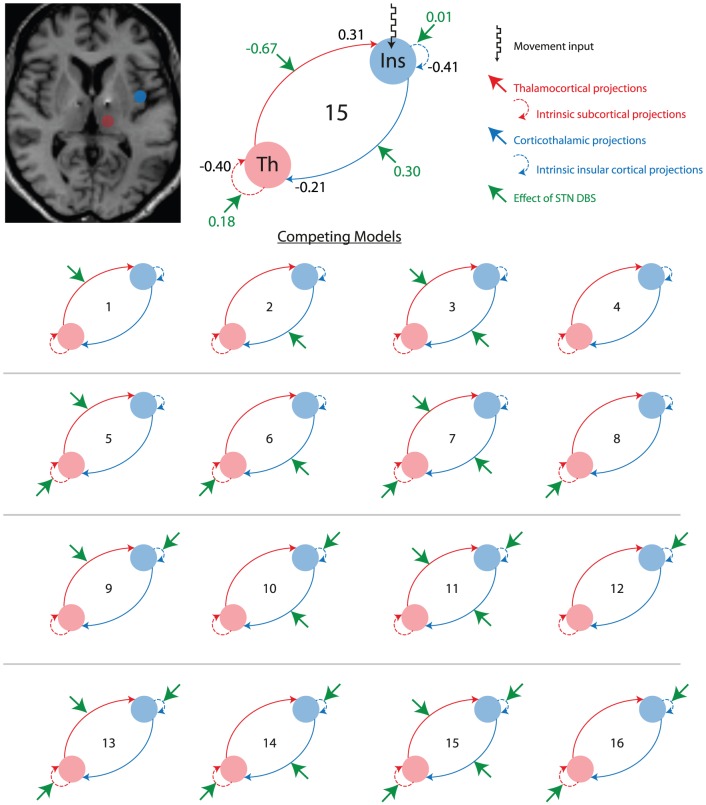
The dynamic causal models compared using Bayesian model selection (model space).Model 15 – the winning model – is shown enlarged. The blue node represents the right insula cortex, and red node, the right thalamus. Green arrows indicate the connection/s that DBS modulates. The ‘movement input’ is likely made up of both motor inputs arriving from M1, PM and SMA, as well as sensory inputs elicited by on-going movements. Thalamic ‘intrinsic subcortical projections’ refer to thalamic afferents from BG nuclei. Cortical ‘intrinsic insula cortical projections’ refer to cortical afferents from within the cortex. Average DCM parameters are included on the enlarged model 15, units are in Hertz (Hz). Positive A-matrix parameters represent an excitatory effect on the target, whereas negative values indicate an inhibition of the target area. Positive B-matrix parameters (value in green) represent an increased target response to input (i.e. an increased gain), whereas negative values indicate a decreased target response to input (i.e. a reduced gain). The coupling during movements with DBS is equal the sum of the A and B value on that connection, e.g. during movements with DBS, the cortico-thalamic drive switches from −0.21 Hz to (−0.21+0.30) = 0.09 Hz, i.e. it switches from an inhibitory to an excitatory drive.